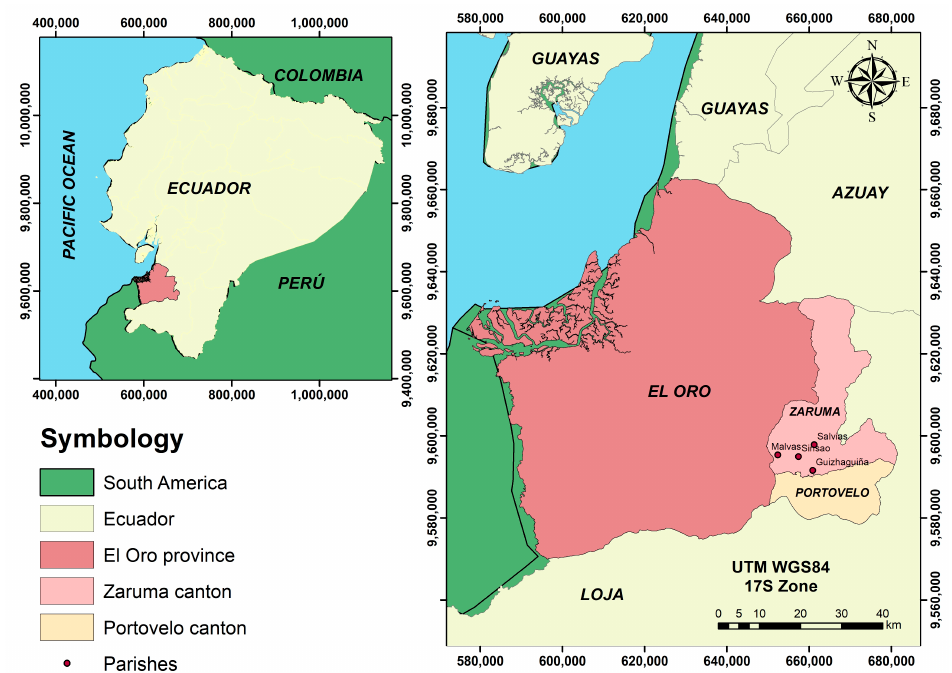
Figure 1. Location map of the study area, Zaruma and Portovelo cantons, belongs to El Oro-Ecuador’s province.